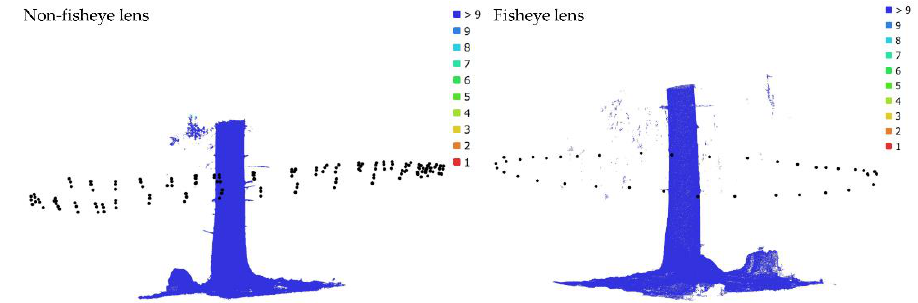
Figure 3. Camera locations and image overlap from the report generated by Agisoft PhotoScan Professional. The same tree is shown on both images ( Abies alba Mill.).